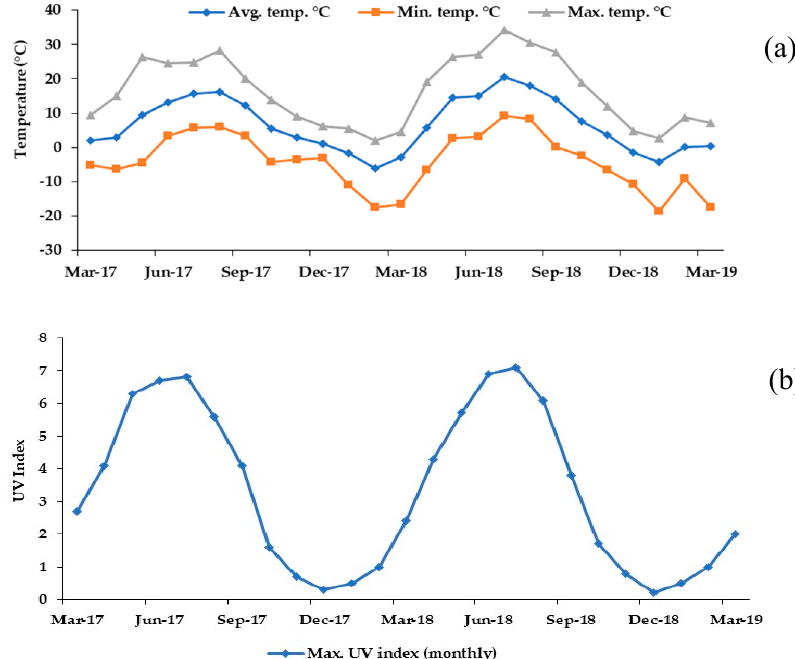
Figure 4. The air temperature ( a ); UV index ( b ) during the 2-year weathering as obtained from Estonian Weather Service Station situated in Harku.